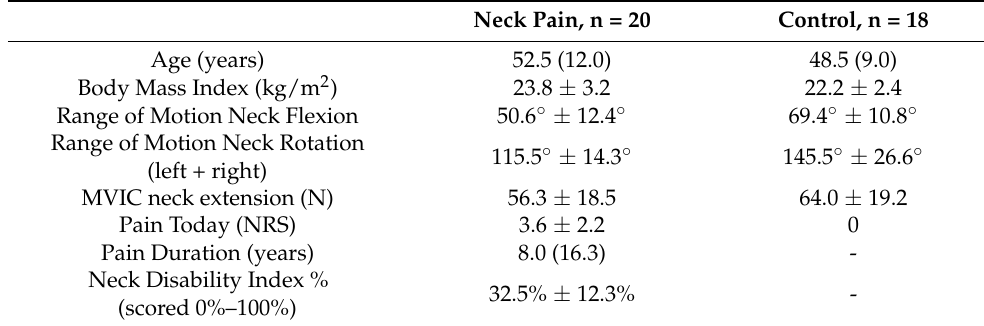
Table 1. Demographic summary: mean ± SD, median (IQR). Abbreviations: MVIC, maximal voluntary isometric contraction; NRS, numerical rating scale; SD, standard deviation; IQR, interquar- tile